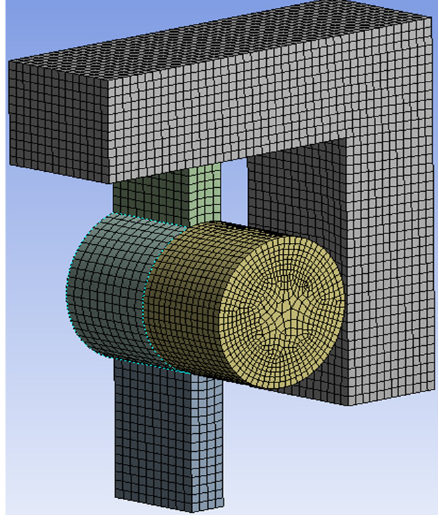
Figure 8. Finite element model.